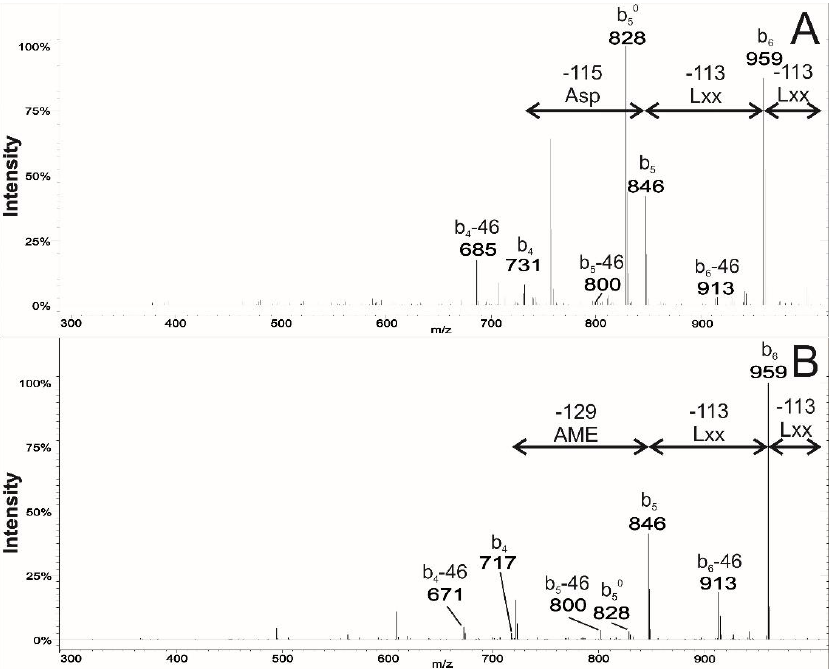
Figure 3. The characteristic fragment ions of C16-[Sur] ( m / z 1072, 30 ; ( A )) and C15-[AME5] ( m / z 1072, 29 , ( B )) resulting via simple cleavage mechanism. AME means the aspartic acid 4-methyl ester residue.